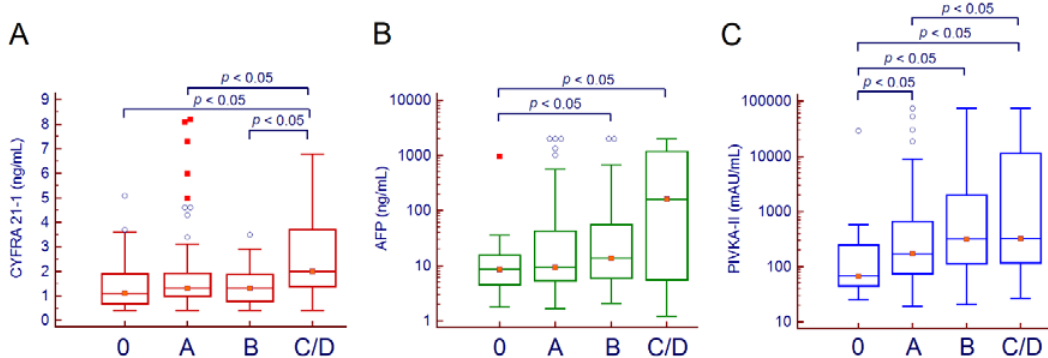
Figure 1. CYFRA 21-1 ( A ), AFP ( B ), and PIVKA-II ( C ) serum levels among the different BCLC stages. Due to the low number of patients with end-stage HCC ( n = 3), patients with BCLC stage C and D were merged. Hollow circles indicate values that are larger than the upper quartile plus 1.5 times the interquartile range while red squares indicate values that are larger than the upper quartile plus 3 times the interquartile range. Abbreviations—alpha-fetoprotein (AFP), Barcelona Clinic Liver Cancer (BCLC), and protein induced by vitamin K absence or antagonist II (PIVKA-II).